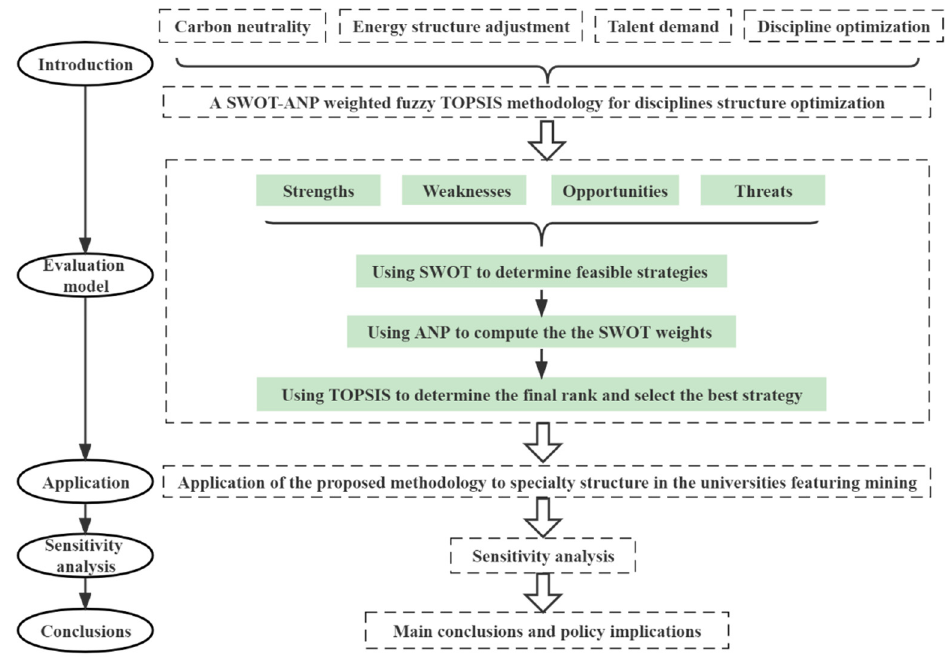
Figure 1. The integrated framework of discipline structure optimization.